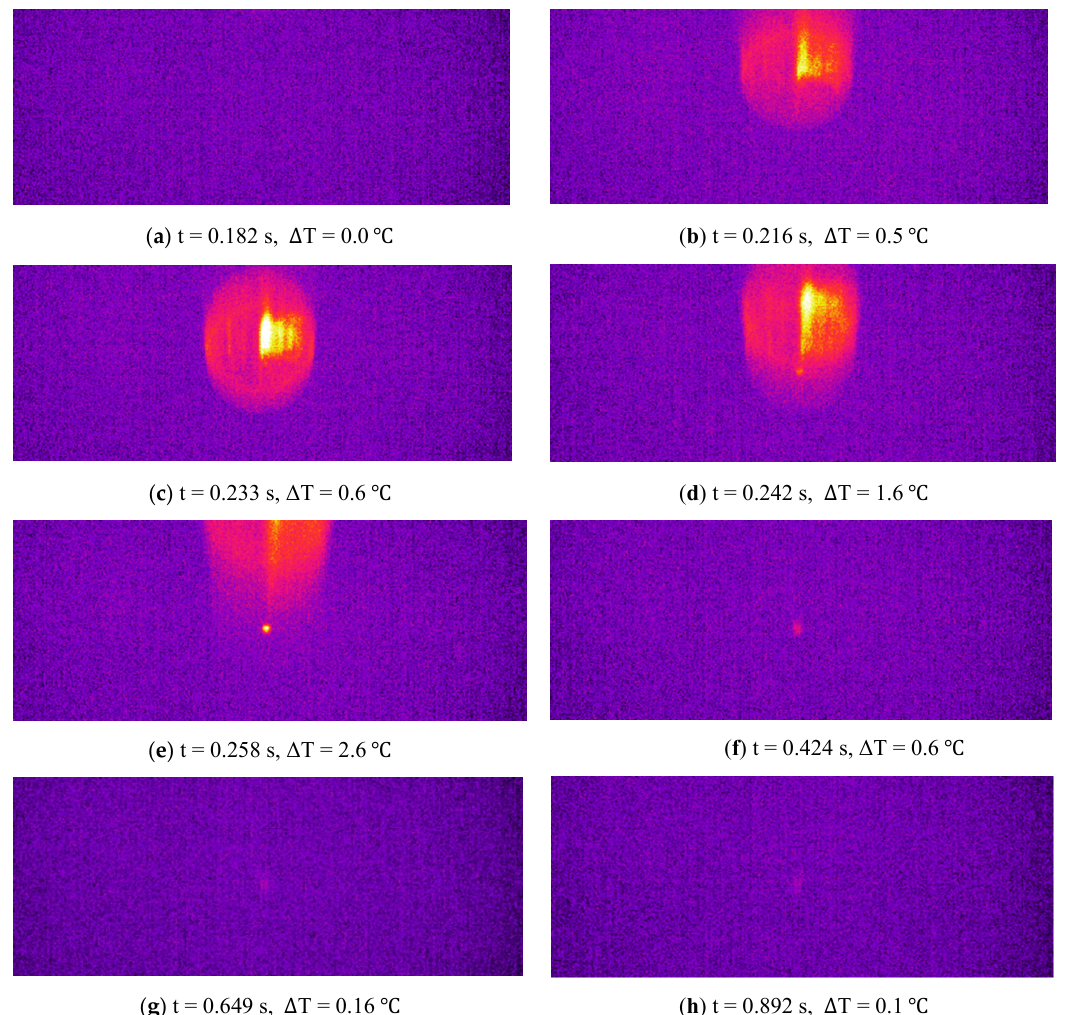
Figure 8. The ∆ T images of the CFRP specimen, impacted with a steel ball. Figure 9 shows the temperature versus time plot of the DWIT as captured through a thermographic imaging technique. The plot indicates a sharp rise in temperature as the ball strikes the CFRP plate; the temperature increased from 21.9 to 24.5 ℃ . After the im- pact, the plate began dissipating energy through diffusion and thermoelastic vibrations, and the plate returned to a constant temperature after t = 0.875 s.